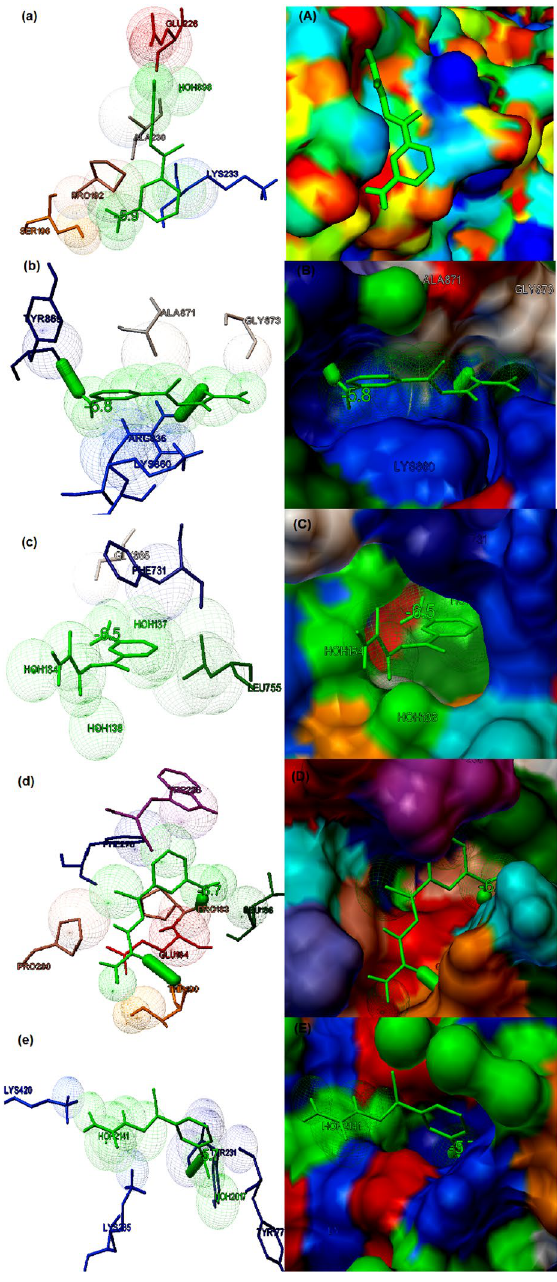
Figure 5. The binding potential of the compound 1 to the five selected cancer receptor studied by molecular docking ( a ) The best binding Interaction of (E)-2-(1-(3-aminophenyl) ethylidene) hydrazinecarboxamide and β-catenin predicted by molecular docking with binding energy of − 5.9 kcal/mol. The ligand is highlighted in green coloured stick figures. The amino acid residues present in the binding activity of the β-catenin receptor is also highlighted ( b ) The best binding Interaction of (E)-2-(1-(3-aminophenyl) ethylidene) hydrazinecarboxamide and Epidermal growth factor receptor (EGFR) with binding energy of − 5.8 kcal/mol. Thick green coloured stuck indicate hydrogen bonding. The ligand is highlighted in green coloured stick figures and the amino acid residues present in the binding activity of the EGFR receptor is also shown in the figure ( c ) The best binding Interaction of (E)-2-(1-(3-aminophenyl) ethylidene) hydrazinecarboxamide and Kinase domain of Human HER2 (erbB2) predicted by molecular docking with binding energy of − 6.5 kcal/mol. The ligand is highlighted in green coloured stick figures and the amino acid residues present in the binding activity of the EGFRK receptor are also highlighted. ( d ) The best binding Interaction of (E)-2-(1-(3-aminophenyl) ethylidene) hydrazinecarboxamide and Cyclin D1-cyclin-dependent kinase 4 with binding energy of − 6.5 kcal/mol. Thick green coloured stuck indicate hydrogen bonding. The ligand is highlighted in green coloured stick figures and the amino acids present in the binding activity of Cyclin D1-cyclin-dependent kinase 4 is also highlighted. ( e ) The best binding Interaction of (E)-2-(1-(3-aminophenyl) ethylidene) hydrazinecarboxamide and RAC-beta serine/threonine-protein kinase B with binding energy of − 6.5 kcal/mol. The ligand is highlighted in green coloured stick figures and the amino acids present in the binding activity of the RAC-beta serine/ threonine-protein kinase B receptor is also shown in the figure. The part shown in uppercase indicate the molecular surface display of the best binding pose of the interaction between the compound 1 and selected cancer